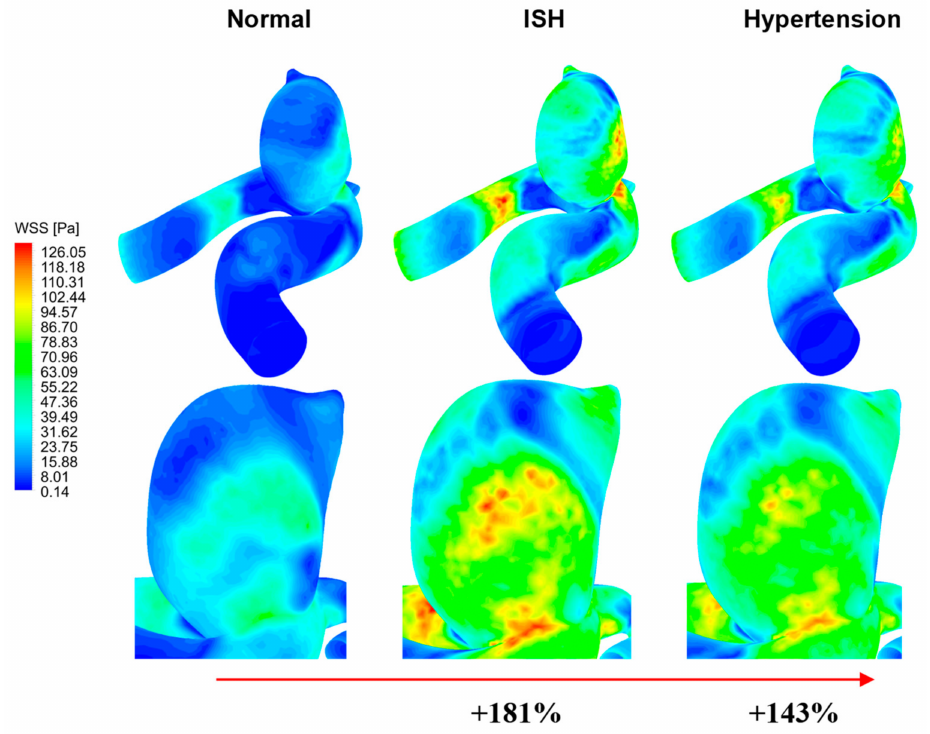
Figure 9. WSS at systole (SWSS) in A-1 model, for each pressure